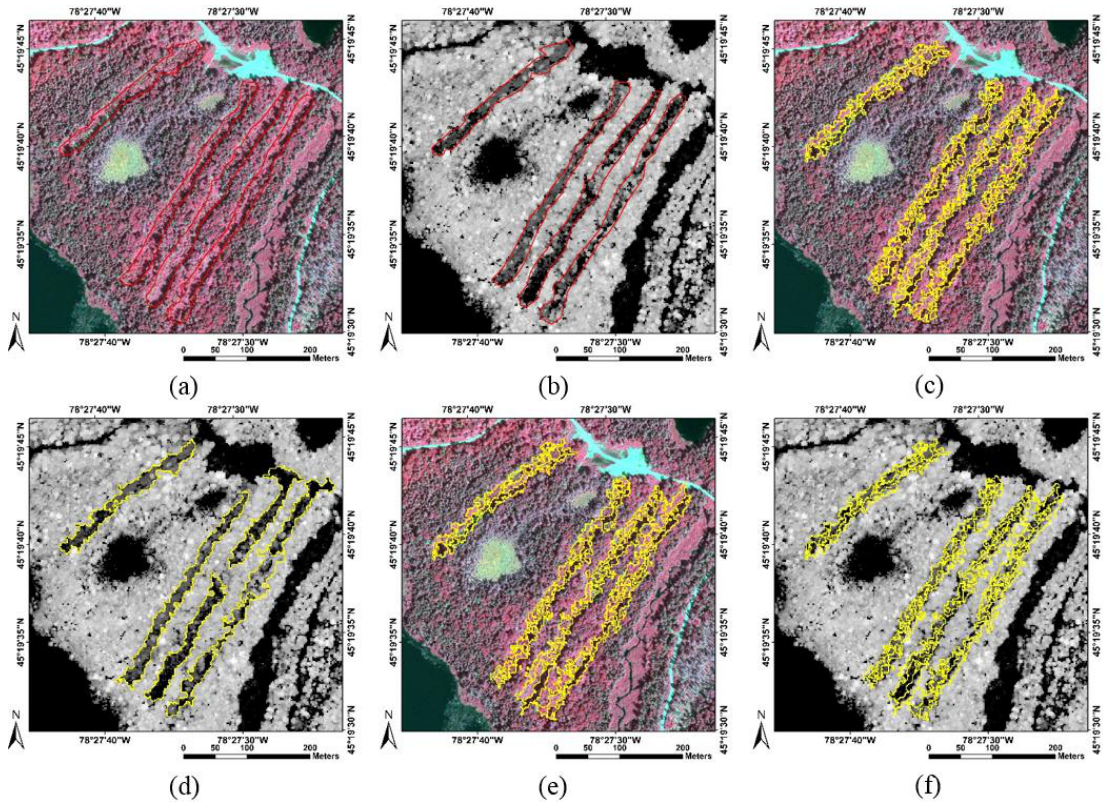
Figure 6. Examples of forest gap segmentation results by different data sources. Tile ( a ) and ( b ) show the reference geo-objects (red polygons) of forest gaps imposed on the multispectral image and CHM, respectively. Tile ( c ) depicts the result of segmentation using the multispectral image at the optimal scale parameter of 10, while Tile ( d ) indicates the corresponding segments by segmenting the CHM at the optimal scale parameter of 20. Both Tile ( e ) and ( f ) show the optimal segmentation result through the integration of multispectral image and CHM at the scale parameter of 10. Table 1. Confusion matrices of object-based canopy gap classifications by spectral, height, and both spectral and height information.